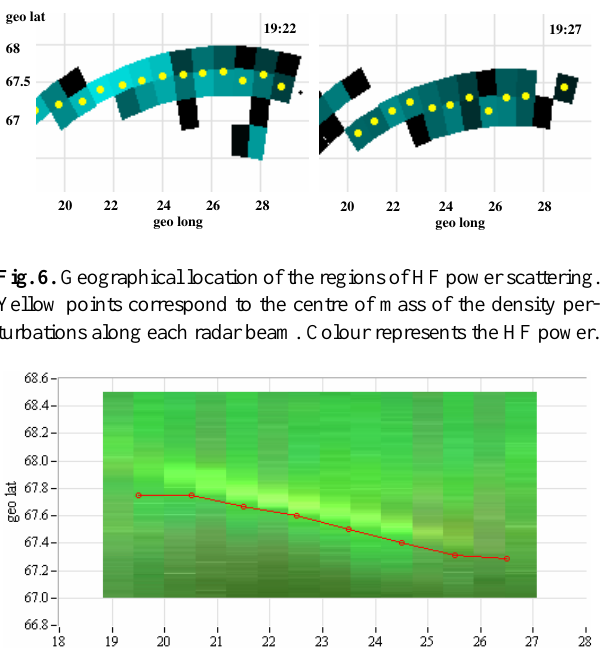
Fig. 7. Latitudinal distribution of light emission versus time, de-